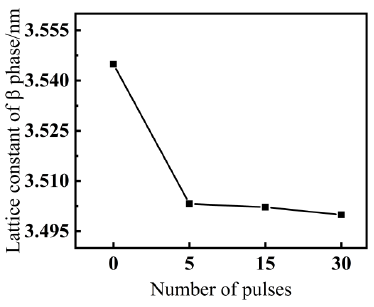
Figure 4: Metallographic image of Zr-17Nb (ST) sample without HCPEB